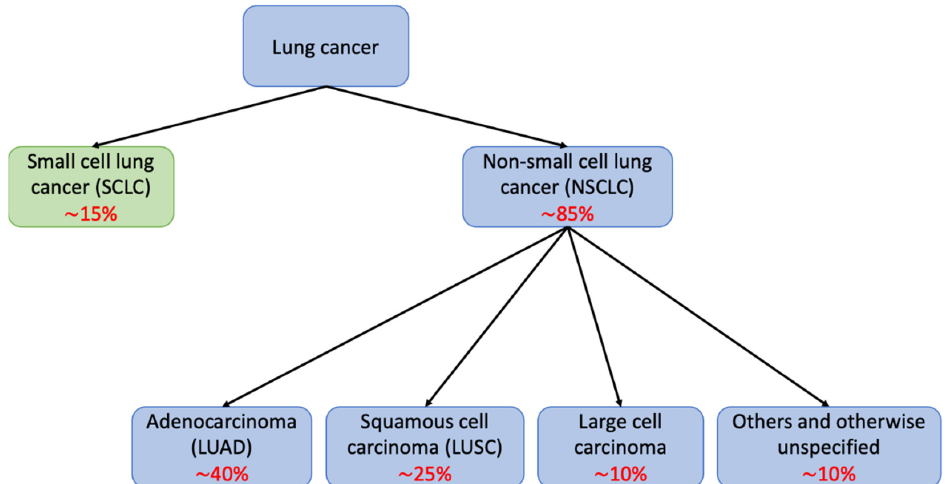
Figure 1. Schematic diagram showing major histological classifications in lung cancer. Lung cancer can be divided into small cell lung cancer (SCLC) and non-small cell lung cancer (NSCLC), which can be further classified into adenocarcinoma, squamous cell carcinoma, large cell carcinoma, and others. In red, approximate frequency of each subtype.